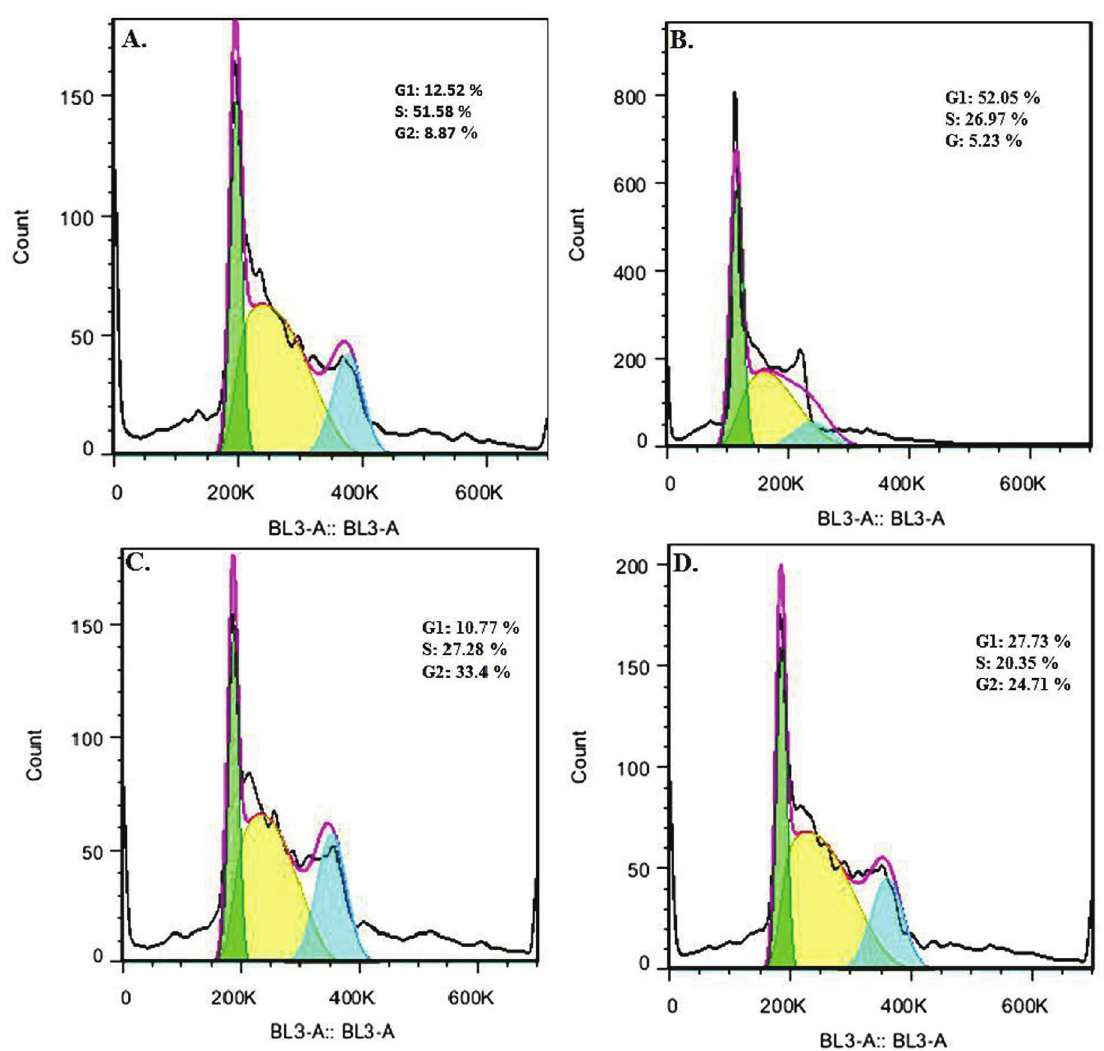
FIGURE 6 - Cell cycle assay using flow cytometry after 48 h. (A) control group (B) cells transduced with pLex-miR-34a (C) cells treated albumin-bound paclitaxel nanoparticles (D) cells that overexpressed miR-34a and treated with albumin-bound paclitaxel